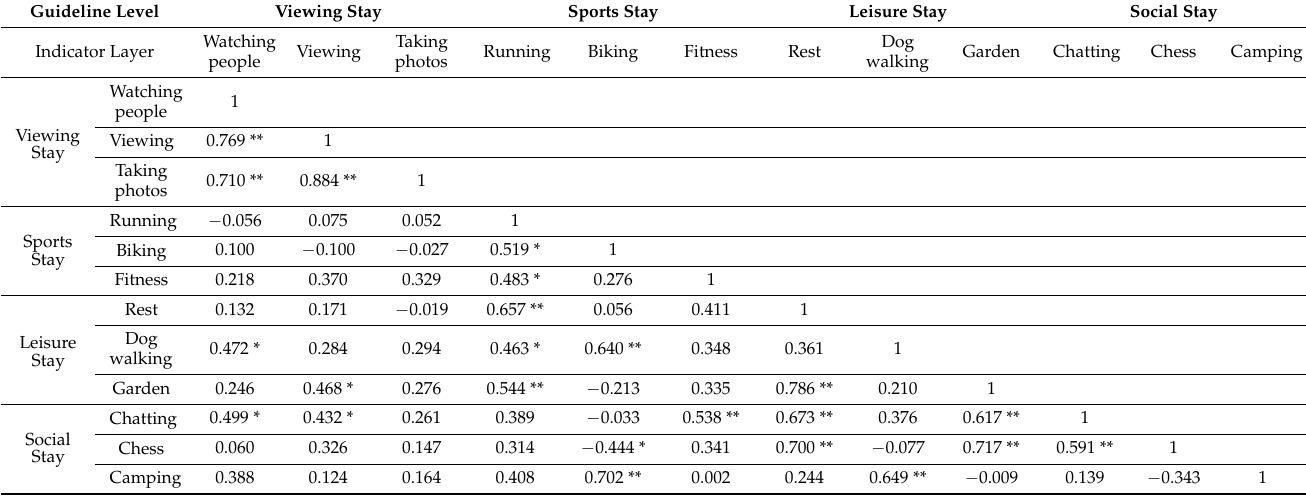
Table 5. Correlation analysis of total stay